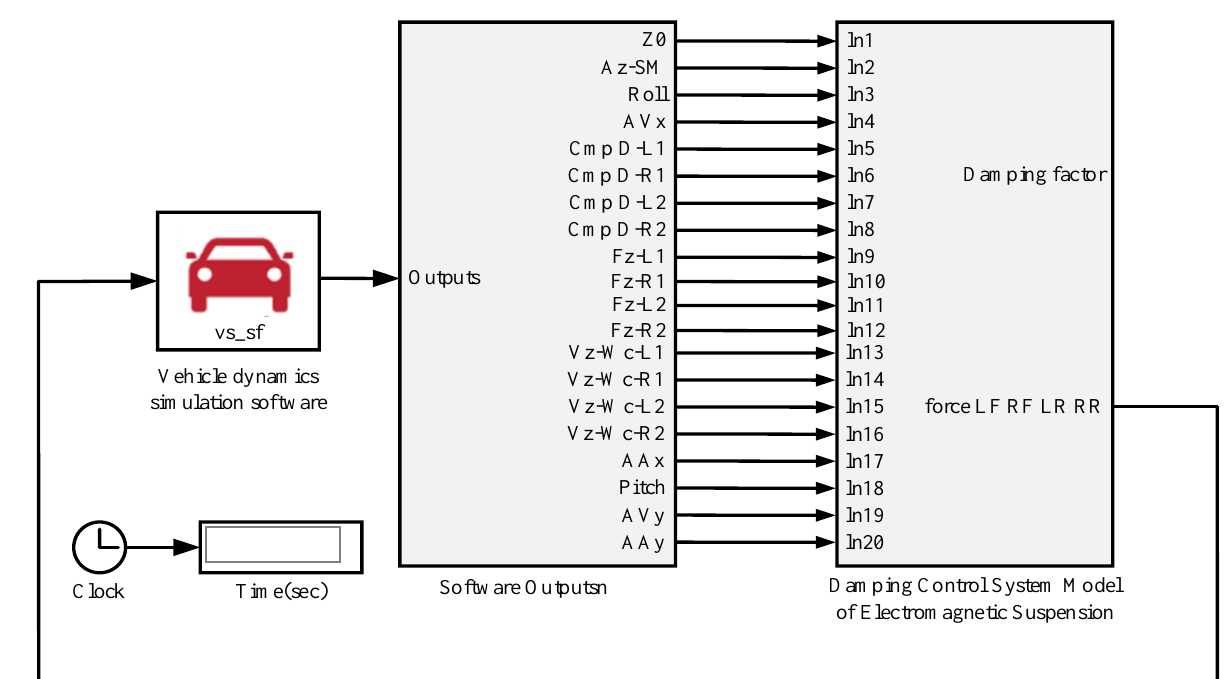
Figure 3. Block diagram of CarSim and Simulink joint simulation.